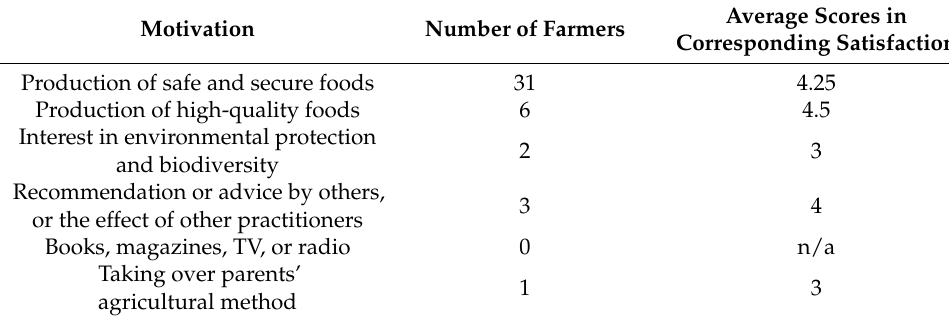
Table 3. Ishikawa Prefecture farmers’ initial motivation and current satisfaction.